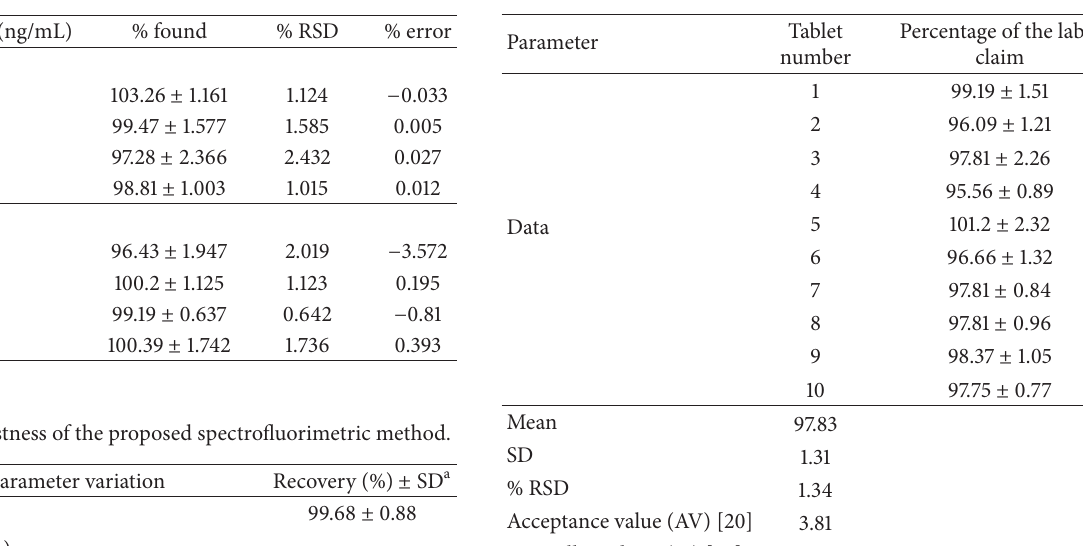
Table 3: Accuracy and precision data for the determination of MRZ by the proposed method.